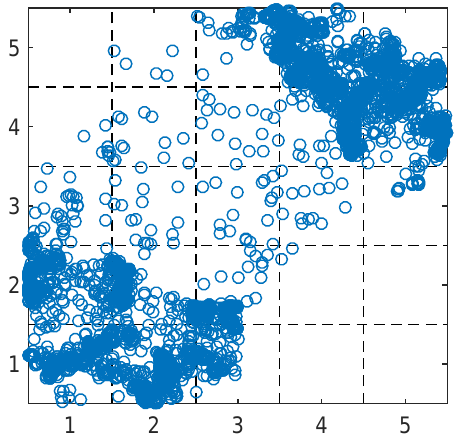
Figure 6. An instant of 6000 crowdsensing nodes generated by SLAW model.